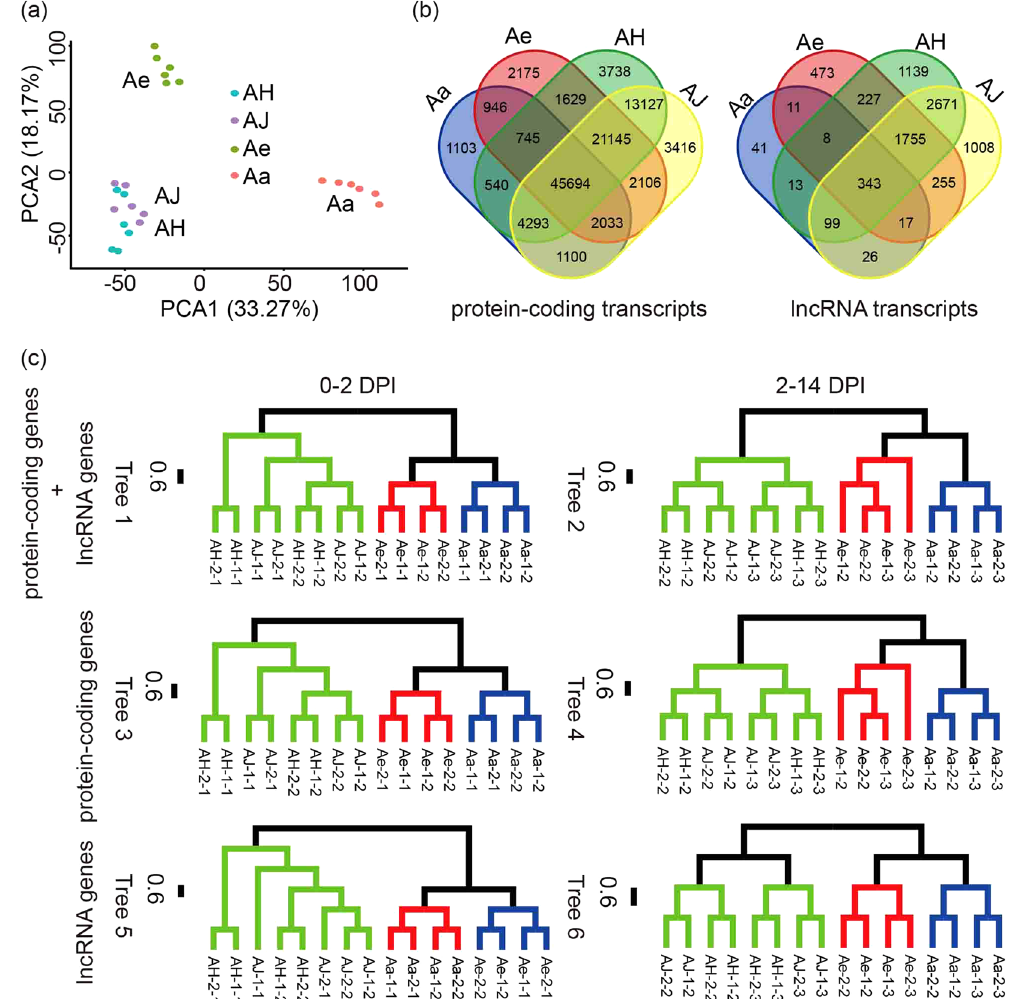
Figure 3. Species-specific expression patterns of differentially-expressed transcripts. ( a ) PCA clustering of both protein-coding and lncRNA transcripts. ( b ) Venn distribution of the respective protein-coding and lncRNA transcripts for each Actinidia material studied. ( c ) Hierarchical clustering of differentially-expressed transcripts for both protein-coding and lncRNA transcripts. The green, red and blue clades represent samples from the species Ac, Ae and Aa